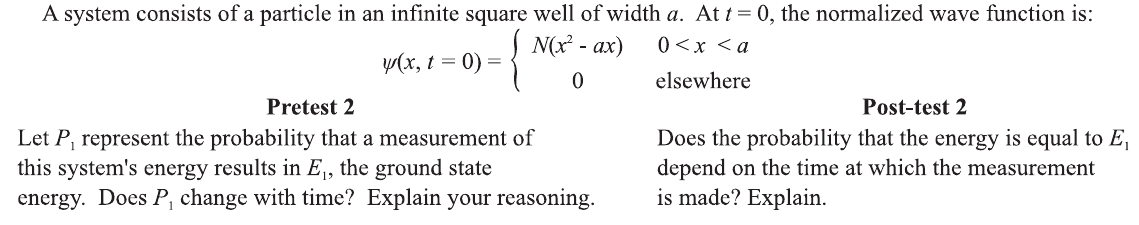
FIG. 4. A pair of questions about the time dependence of energy probabilities. The pretest was given after lecture instruction on time dependence but before the tutorials. The post-test was given after the full sequence of tutorials, as part of the same exam as post-test question